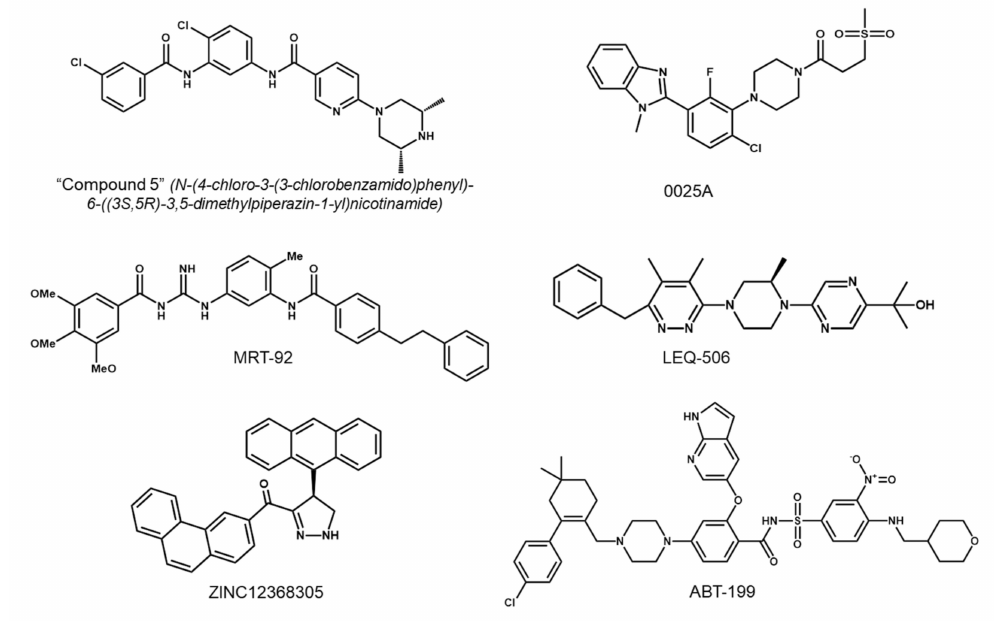
Figure 6. Chemical structures of the selected second-generation SMO inhibitors under